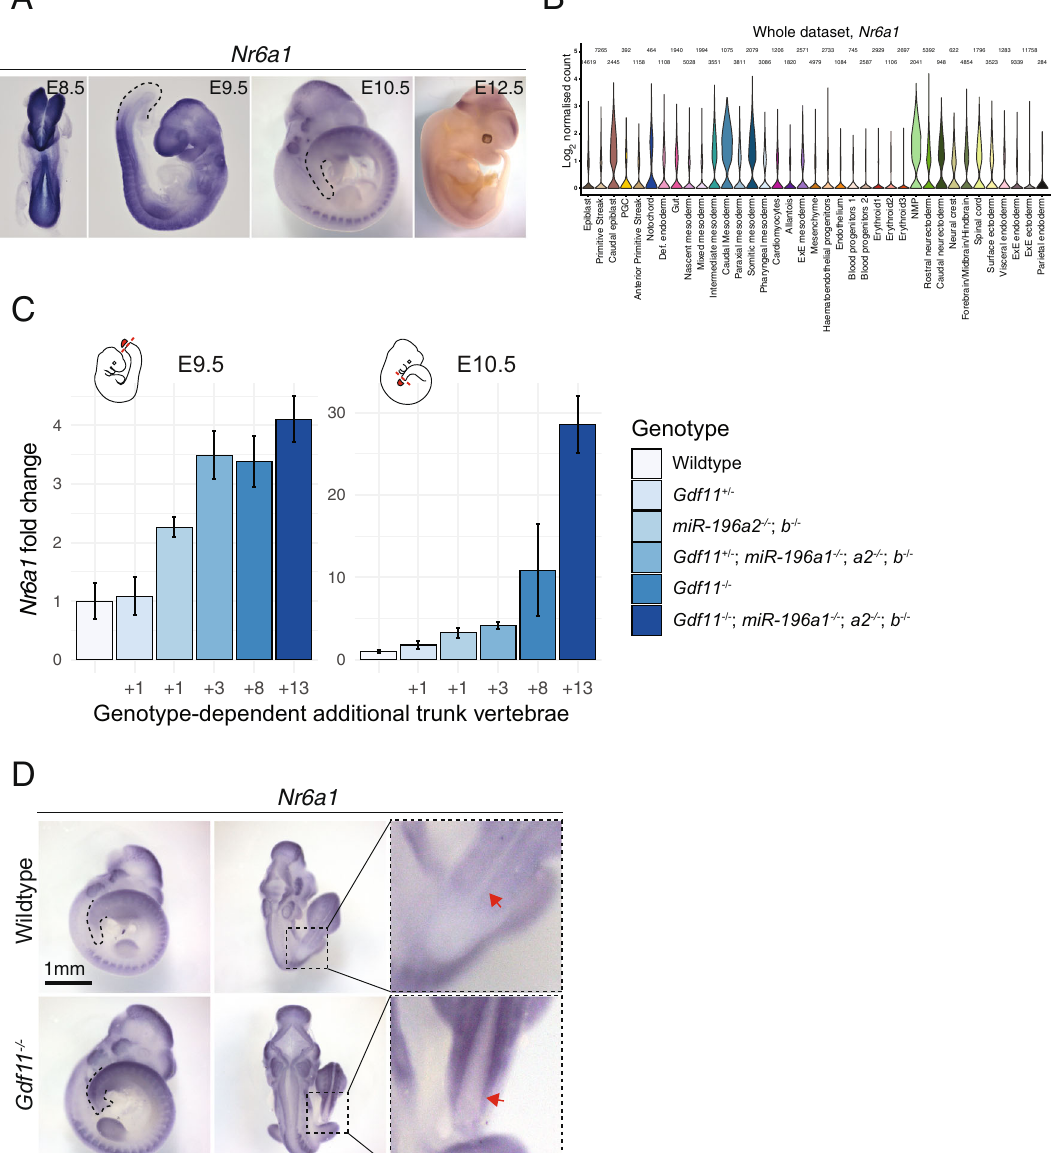
compound mutant embryos, represented as a fold change compared to wildtype (de fi ned as 1). The number of biologically independent samples assessed: WT E9.5 n =3, E10.5 n =4; Gdf11 +/ − E9.5 n =3, E10.5 n =3; miR-196a2 − / − ;b − / − E9.5 n =3, E10.5 n =4; Gdf11 +/ − ; miR-196a1 − / − ;a2 − / − ;b − / − E9.5 n =3, E10.5 n =4; Gdf11 − / − E9.5 n =3, E10.5 n =2; Gdf11 − / − ; miR-196a1 − / − ;a2 − / − ;b − / − E9.5 n =3, E10.5 n =2; Error bar represents standard deviation. Source data are provided as a Source Data fi le. The number of additional thoraco-lumbar vertebrae observed across the allelic deletion series 44 is indicated. D Whole mount in situ hybridisation reveals that the quantitative increaseof Nr6a1 inE10.5 Gdf11 − / − tailbudtissuerelativetowildtypere fl ectsalackof timely clearance from the posterior growth zone. Consistent spatial changes were observed in2biologicallyindependentsamples/genotype.Redarrowindicatesthe neural